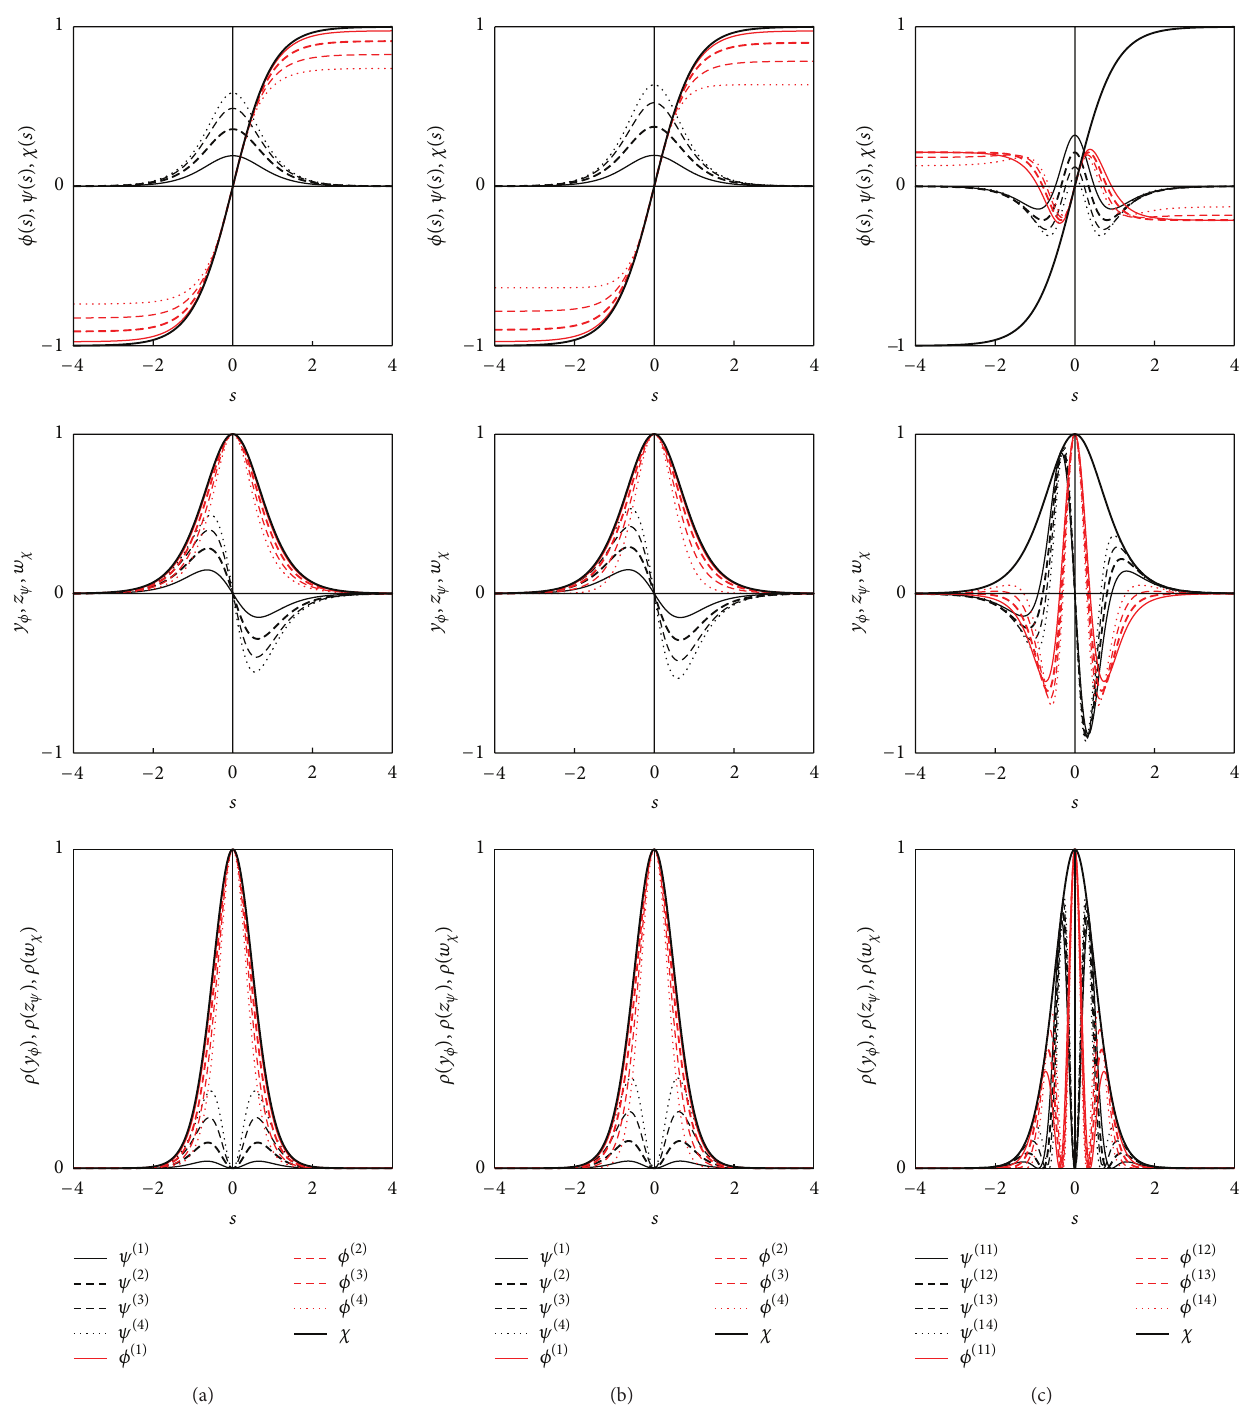
Figure 3: The 3 -cyclic deformed defects obtained from hyperbolic (first column) and trigonometric (second and third columns) deformation functions. Results are for the primitive 𝜆𝜒 4 kink solution, 𝜒(𝑠) (thick black line), for the kink-like deformed defects, 𝜓 (𝑛) (𝑠) (black lines), and for the lump-like deformed defects, 𝜙 (𝑛) (𝑠) (red lines). The free parameter 𝑛 was set equal to 𝑘𝜋/8 with 𝑘 assuming the following integer values in the first/second (third) columns: 1(11) for solid lines, 2(12) for long-dashed lines, 3(13) for short-dashed lines, and 4(14) for dotted